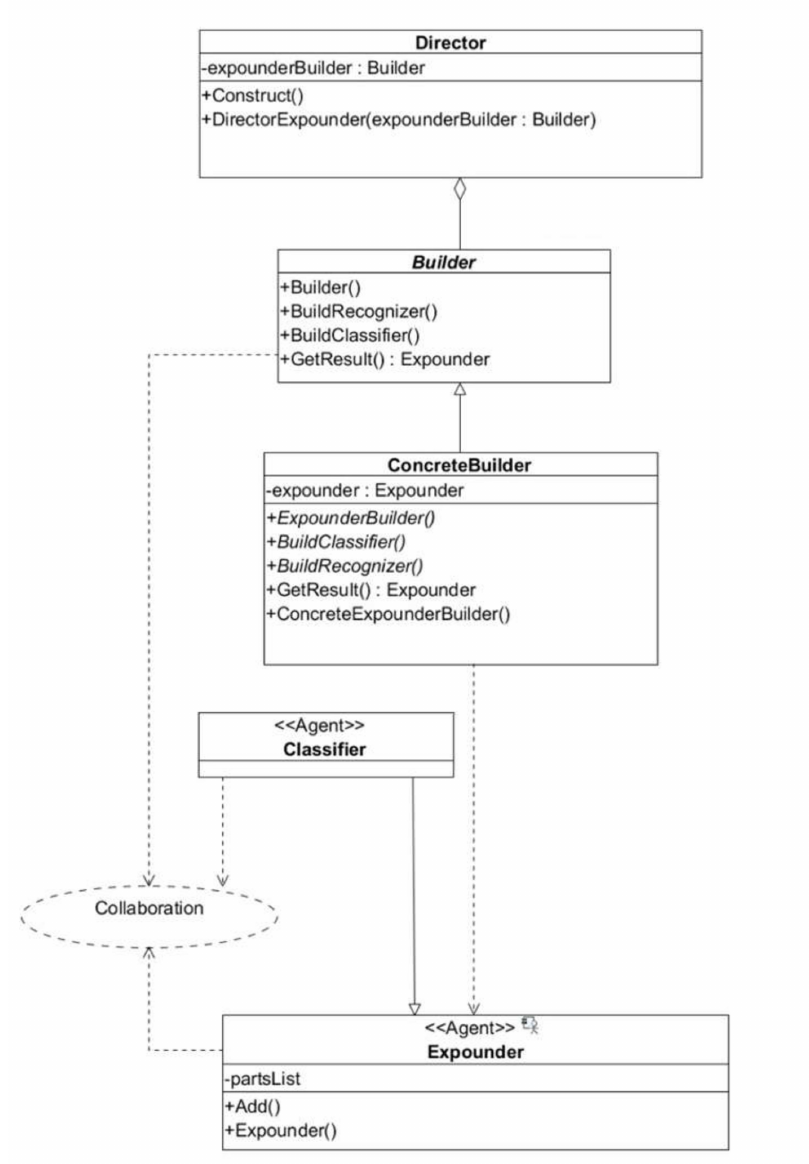
Figure 4. Expounder hybridization